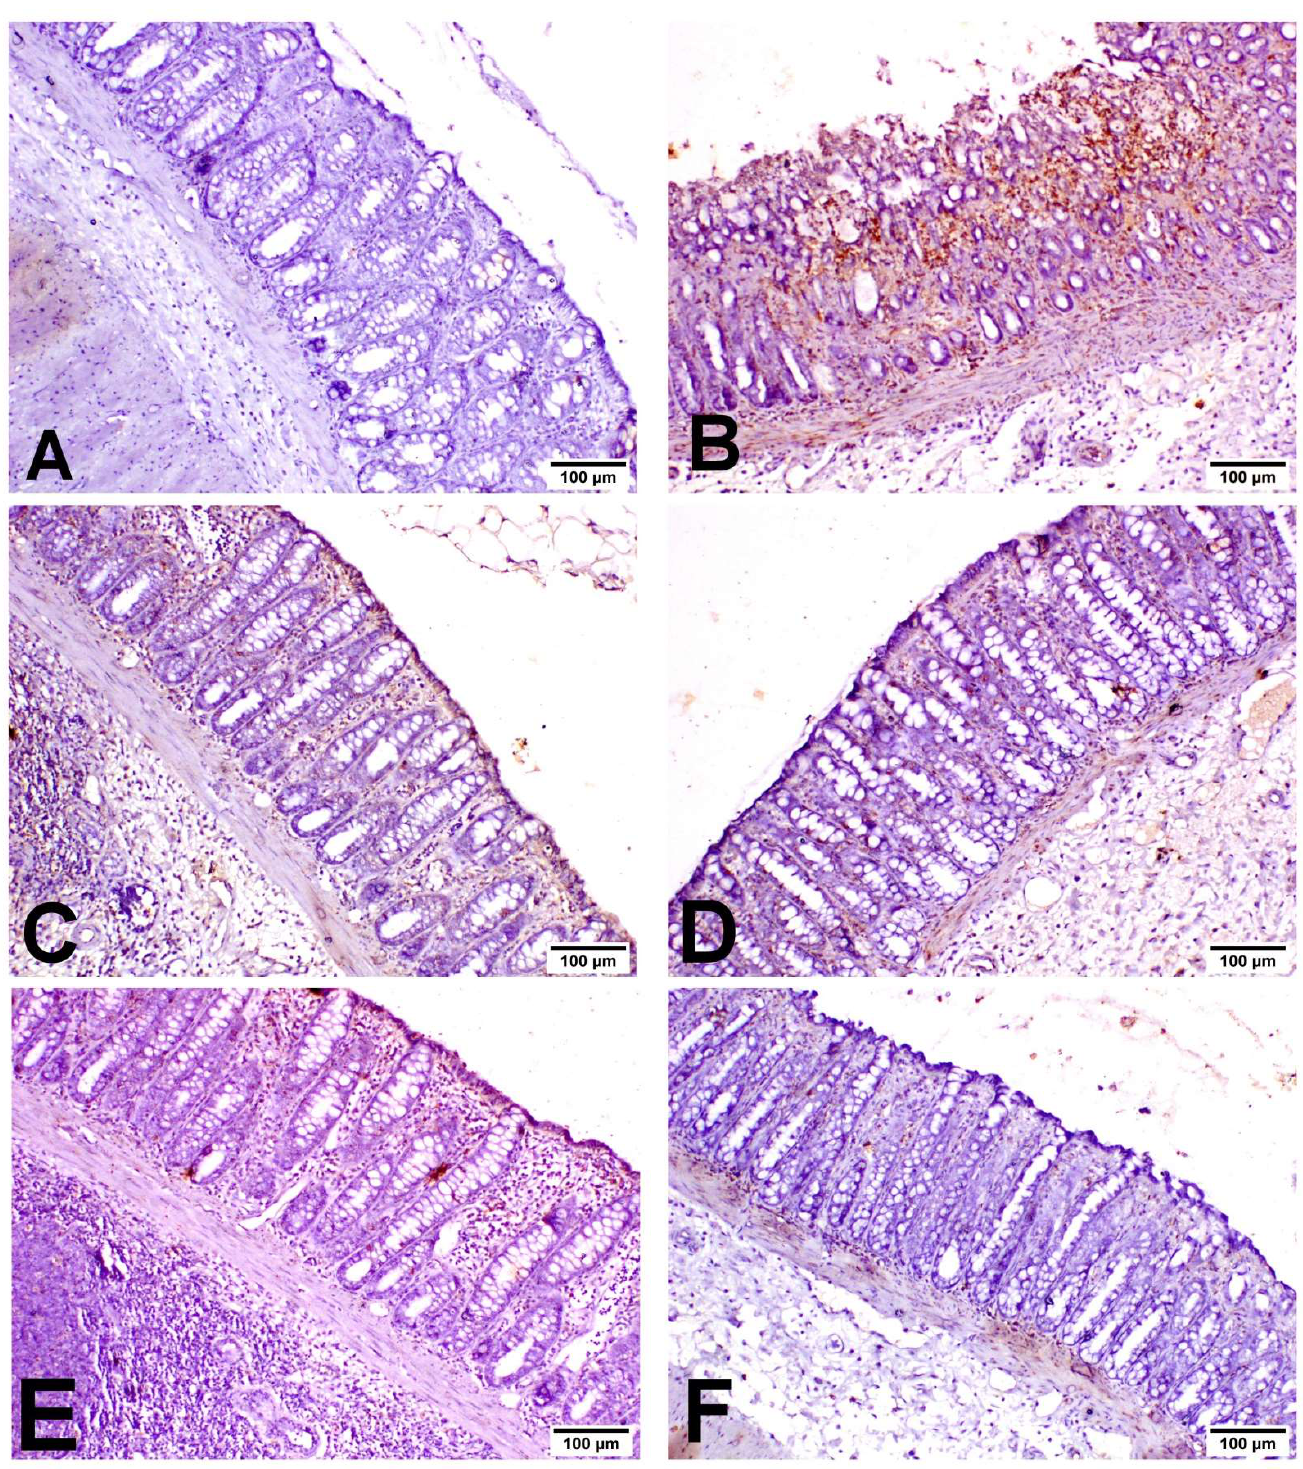
Figure 6. Immunohistochemistry of COX2 expression in the colon of the different groups: ( A ) NC group; ( B ) UC group; ( C ) MIC-20 group; ( D ) MIC-40 group; ( E ) SSZ-100 group; ( F ) MIC + SSZ group.